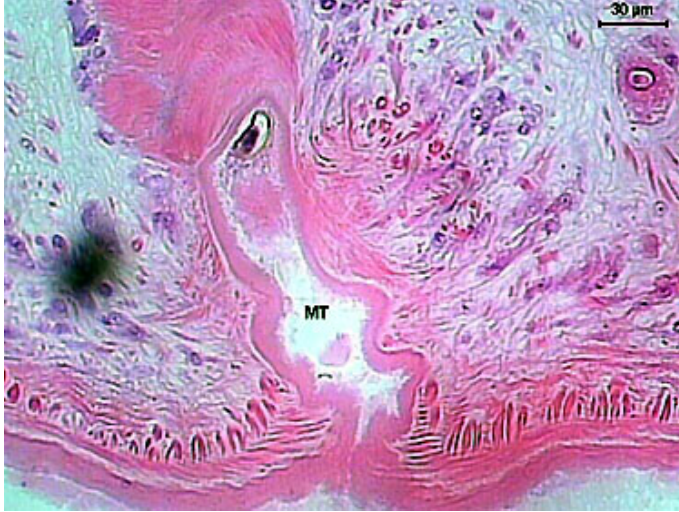
Figure 19. Transversal section of the Sticholecitha serpentis metraterm (MT).